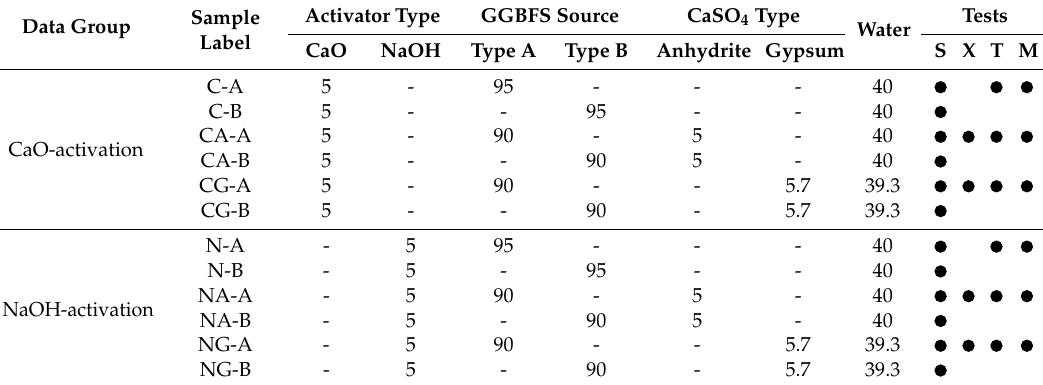
Table 2. Mixture proportions of prepared paste samples in wt.% and conducted tests. Data